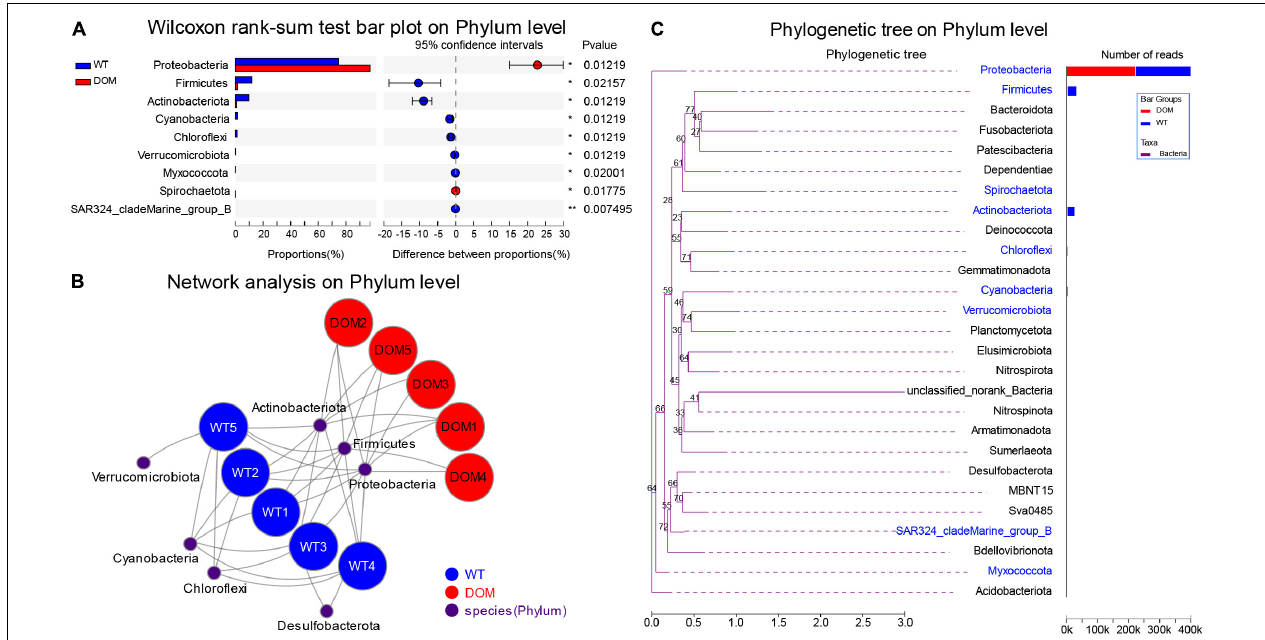
FIGURE 5 | Microbial comparison and interaction analysis at phylum level in A. grunniens intestine domesticated with compound feed. (A) Differentially colonized microbial communities at phylum level; (B) interaction network between microbial communities and A. grunniens individuals; and (C) Phylogenetic analysis at the phylum